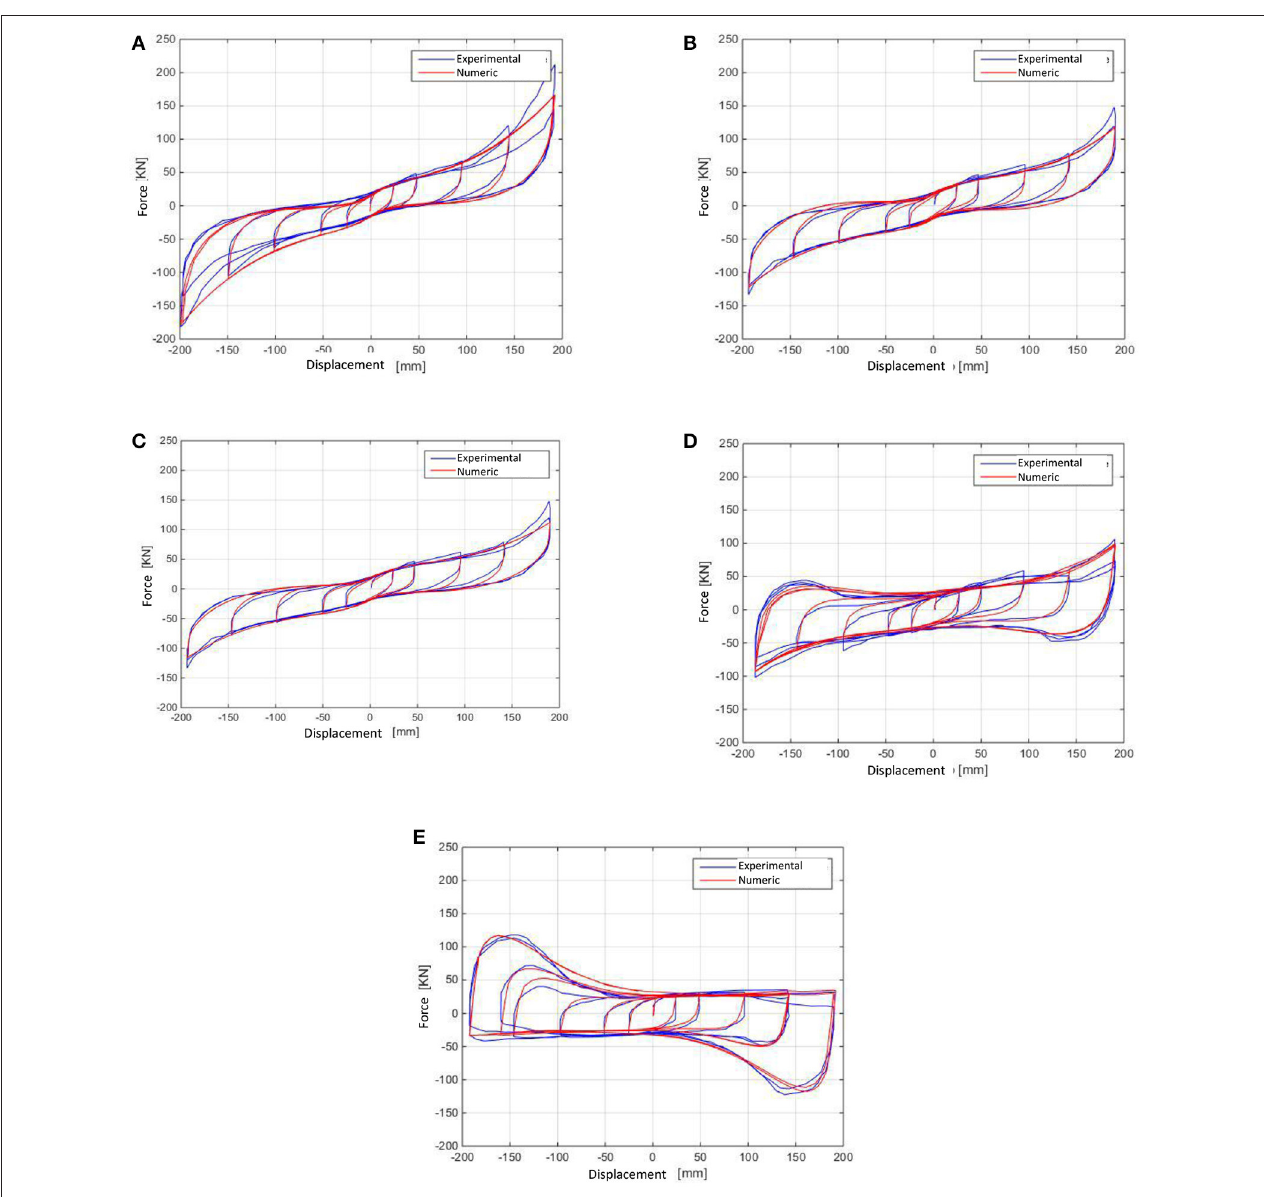
FIGURE 4 | Pattern Search method: cyclic shear test of the tested isolator (50, 100, 200, 300, and 400% deformations for compression stresses of 0 MPa (A) , 5 MPa (B) , 10 MPa (C) , 20MPa (D) , 30MPa (E) . Comparison between model (parameters in Table 3 ) and experimental results.